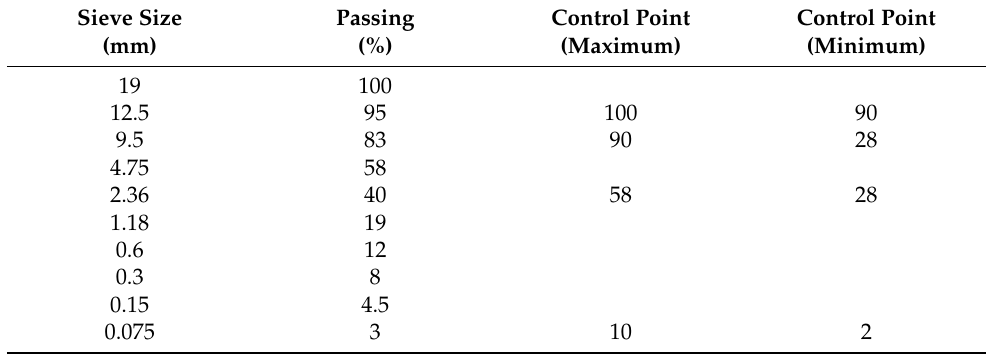
Table 4. Size distribution of aggregate